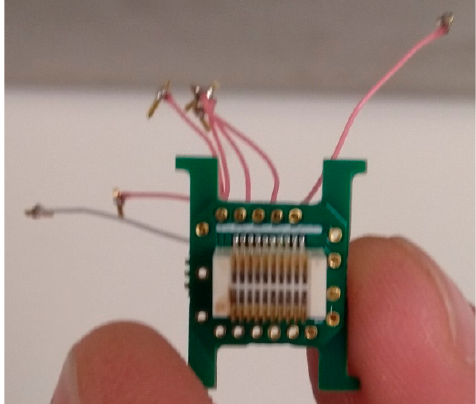
Figure 3. Implanted electronic interface board (EIB) microchip showing electroencephalograph (EEG) channel, reference channel wires and electrodes.